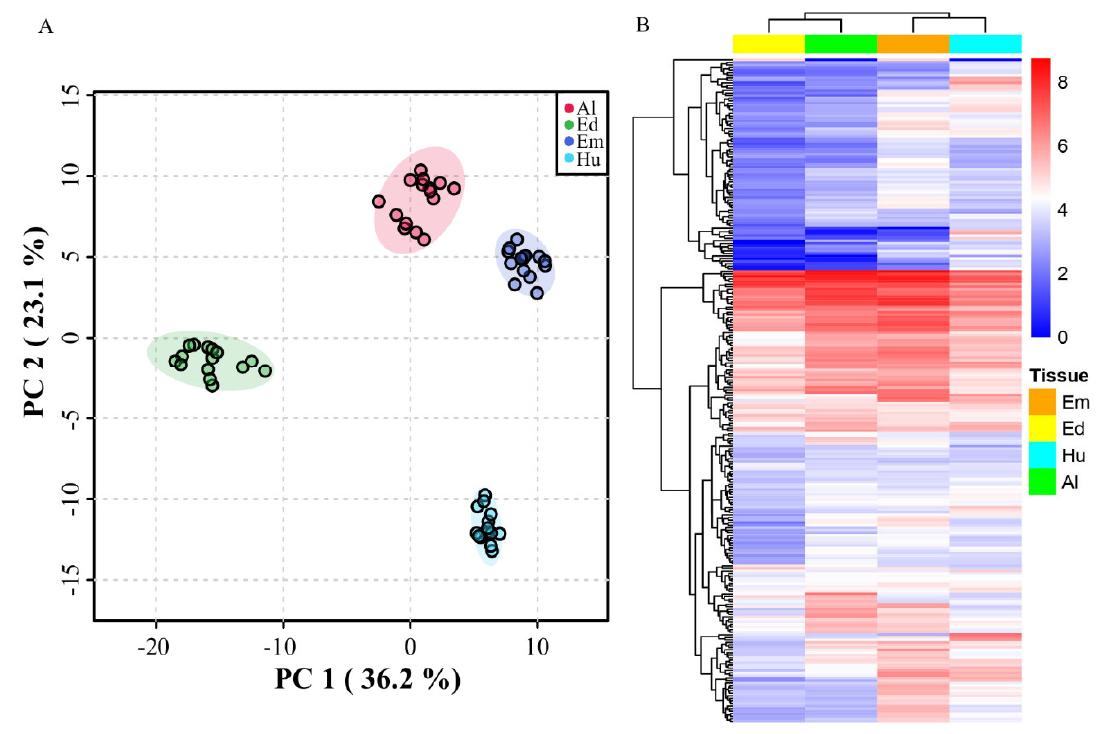
Figure 9. General analysis of metabolites in four non-storable NILs and ZS97. PCA ( A ) and heatmap